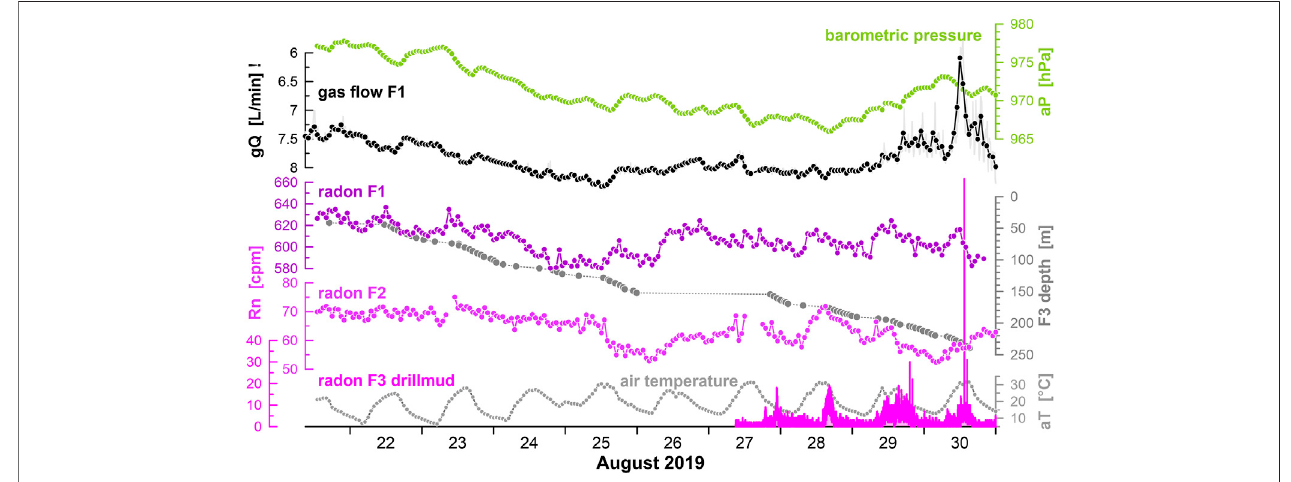
FIGURE 2 | Hourly averages of barometric pressure, gas fl ow rate of F1, radon concentration of F1 and F2 as well as in the drillmud of F3 (1-min raw data), and air temperature during the drilling phase. Note the inverted Y -axis of the gas fl ow. Drill depths estimated from core-on-deck times.